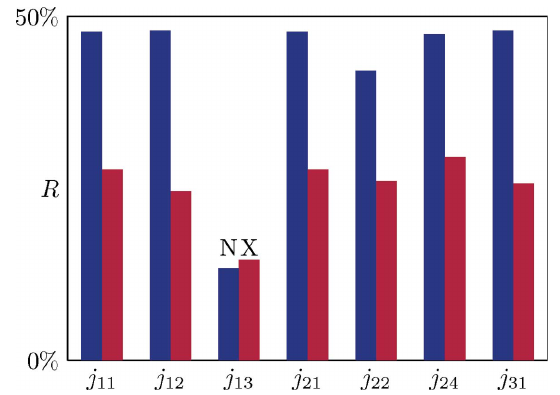
Figure 4 The variation in R values for the model-agnostic MF refinement with the different j xy of equation (12). Neutron scattering (N) values are shown in blue and X-ray scattering (X) in